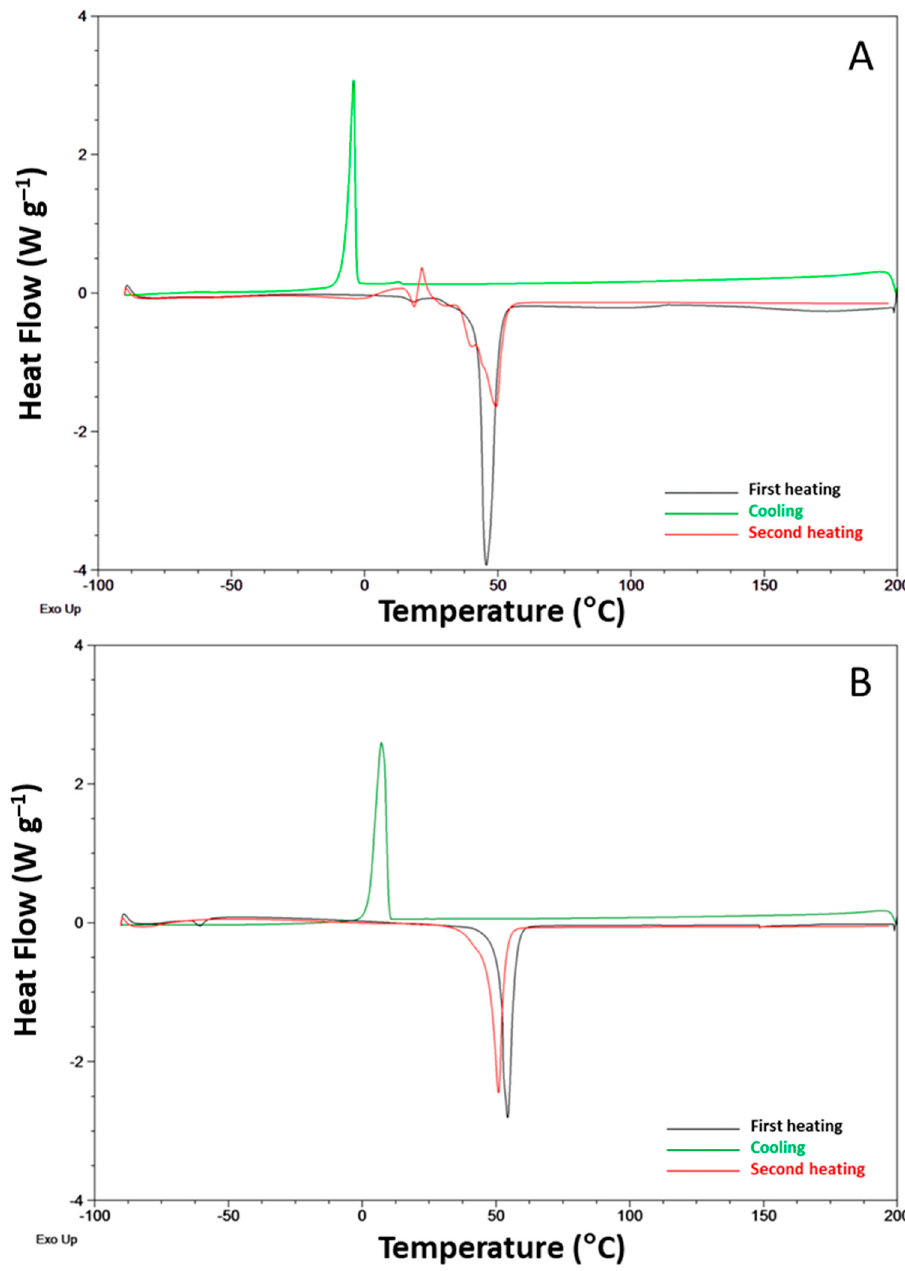
Figure 5. DSC traces for the neat ILs. ( A ) IL1 (HdmimDMSIP); ( B ) IL2 (OOMmimPF 6 ).